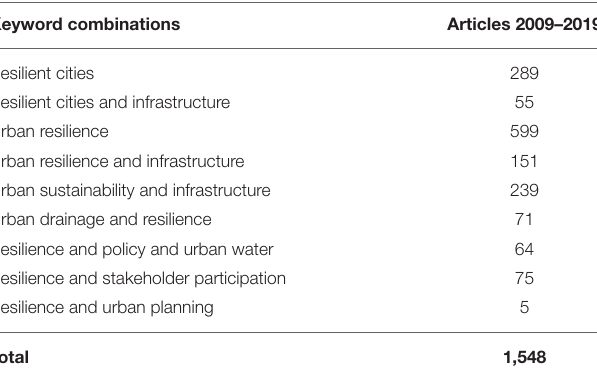
TABLE 1 | Summary of articles founded of each keyword’s